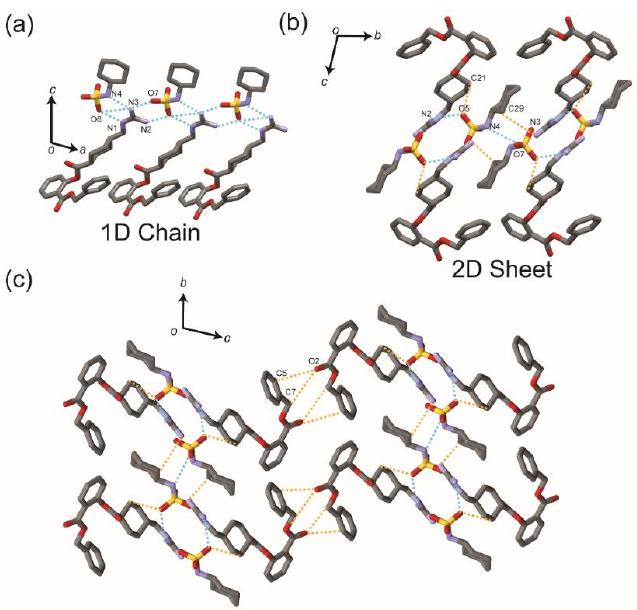
Figure 5. ( a ) 1D chain and ( b ) 2D sheet structures in the BEX – CYM crystal. ( c ) The 2D sheet structure is stacked along the a -axis through C5 – H···O2 and C7 – H···O2 hydrogen bonds. Conventional and non- conventional hydrogen bonds are drawn by dashed blue and orange lines, respectively. Hydrogen atoms have been omitted for clarity.